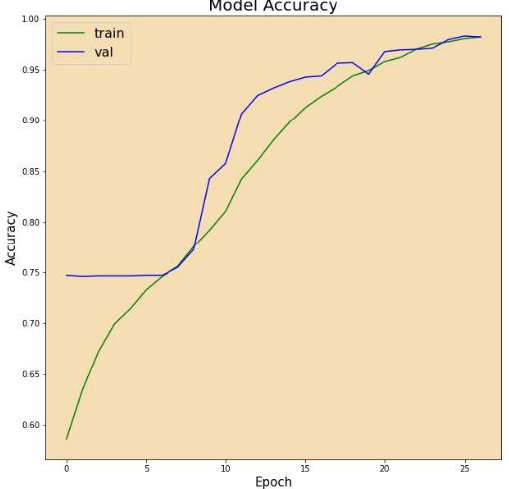
Figure 7. Model accuracy before using cGAN.